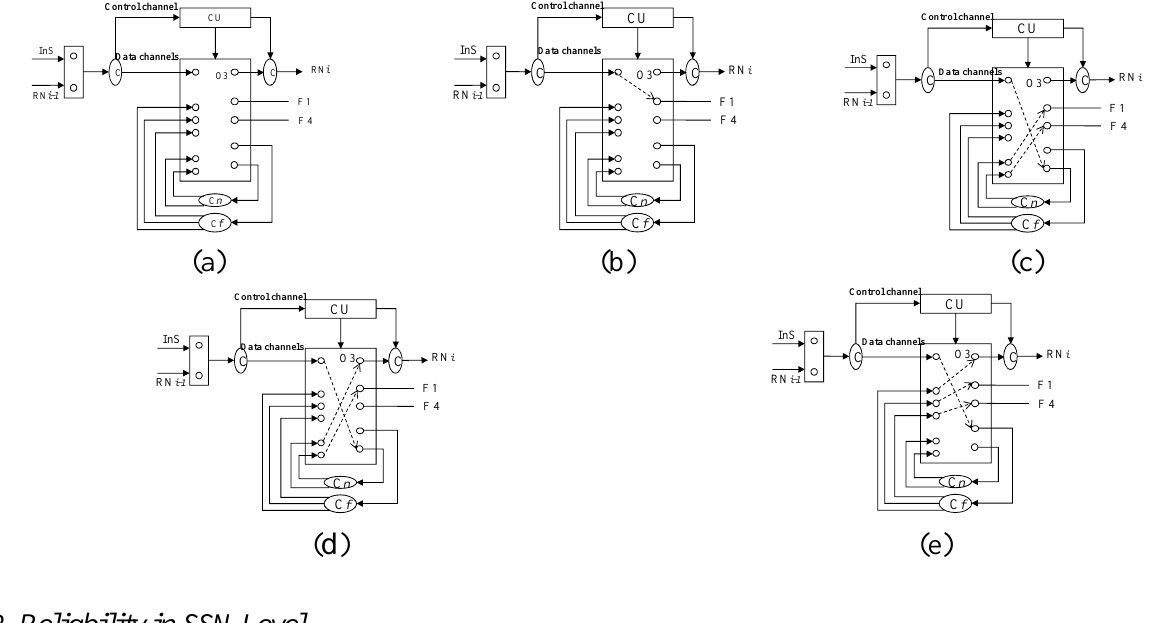
Figure 4. (a) Switch architecture of RN; (b) Normal case; (c) Failure in level 3; (d) Failure between level 1and 2; (e) Failure between level 1 and 2, within level